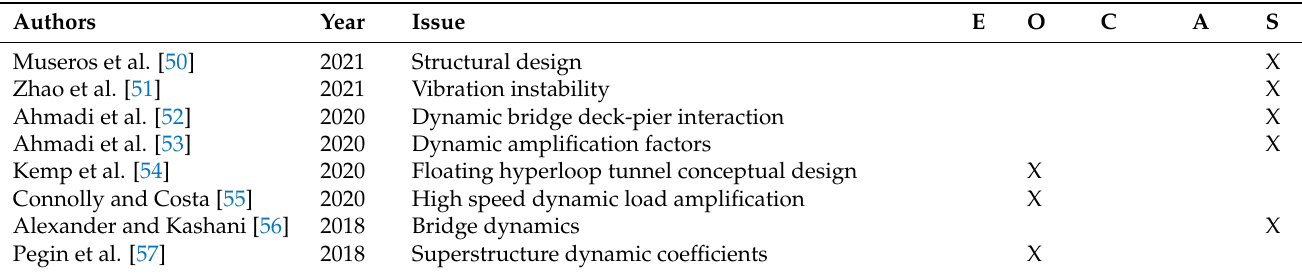
Table 2. Issues identified in research on Hyperloop substructure.